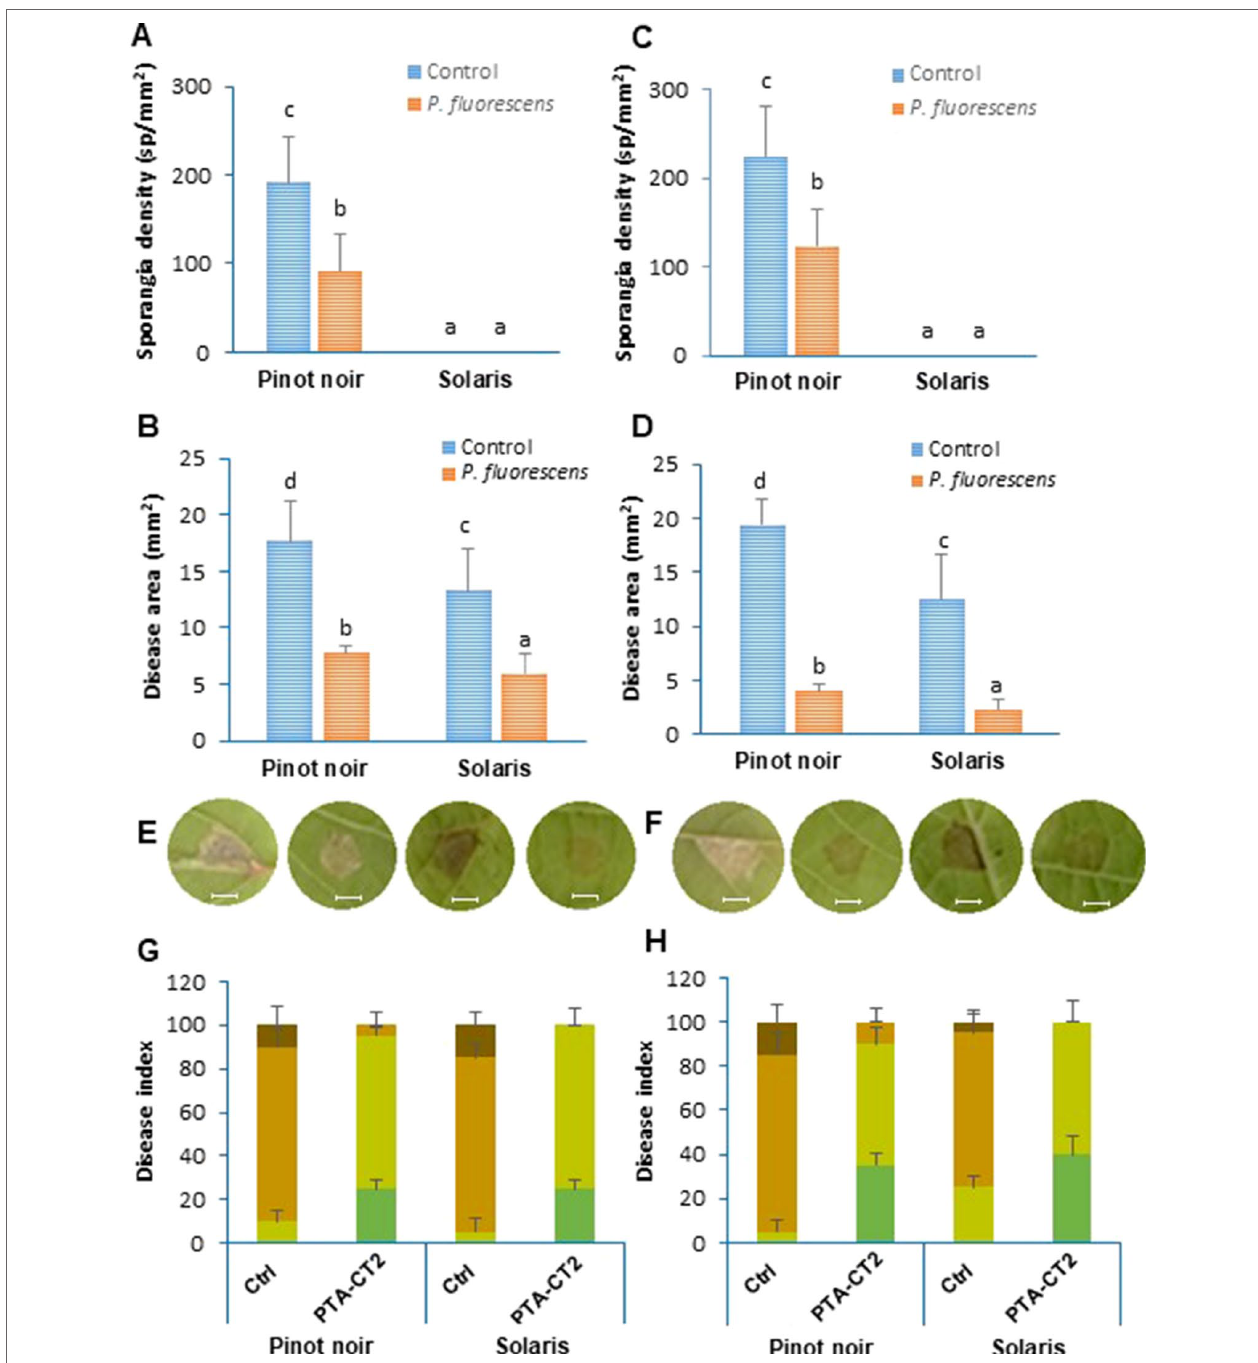
FIGURE 4 | Pseudomonas fluorescens PTA-CT2 strengthens systemic resistance against Plasmopara viticola in both susceptible cultivar Pinot noir and partially resistant cultivar Solaris. Plants were treated at the root level with P. fluorescens at 10 7 CFU g −1 soil, and 2 weeks later, leaf disks were excised from the upper third and fourth leaves and infected with 20 µl of 10 5 spores per milliliter of P. viticola . Sporangia density was quantified using Malassez hemocytometer at 7 days post infection (dpi) (A, B) , and necrotic lesions covered or not with spores were evaluated 7 dpi by Compu Eye, Leaf & Symptom Area (LSA) software (C, D) . Photographs (E, F) depict the representative disease symptoms on leaf disks of control and PTA-CT2-treated plants at 7 dpi. Bars = 4 mm. Disease index (G, H) was expressed as the fraction of leaf disks falling in the following classes: dark green, no visible symptom; light green, lesion covering 5–10 mm 2 ; light brown, lesion covering 10–20 mm 2 ; dark brown, lesion covering more than 20 mm 2 of the leaf disk area. Data are the means from three independent experiments, each experiment was performed with 30 leaves for each condition in 2016 (A, C, E, G) and 2017 (B, D, F, H) , and vertical bars indicate standard deviation. Different letters indicate statistically significant differences between the treatments (ANOVA Tukey test, P <